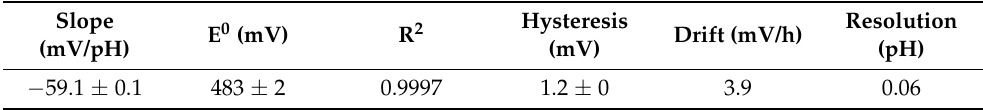
Figure 6. Potential recording for the developed pH sensor in pH buffers 7 − 2 − 7 − 12 − 7, and 7 − 4 − 7 − 10 − 7 three times. Table 6. Summary of the pH sensing performance of the developed TiN pH sensor. The data are extracted from Table